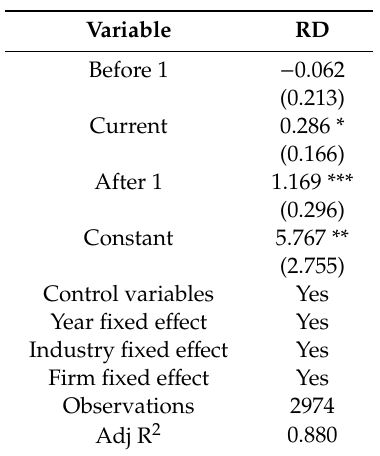
Table 4. Parallel trend